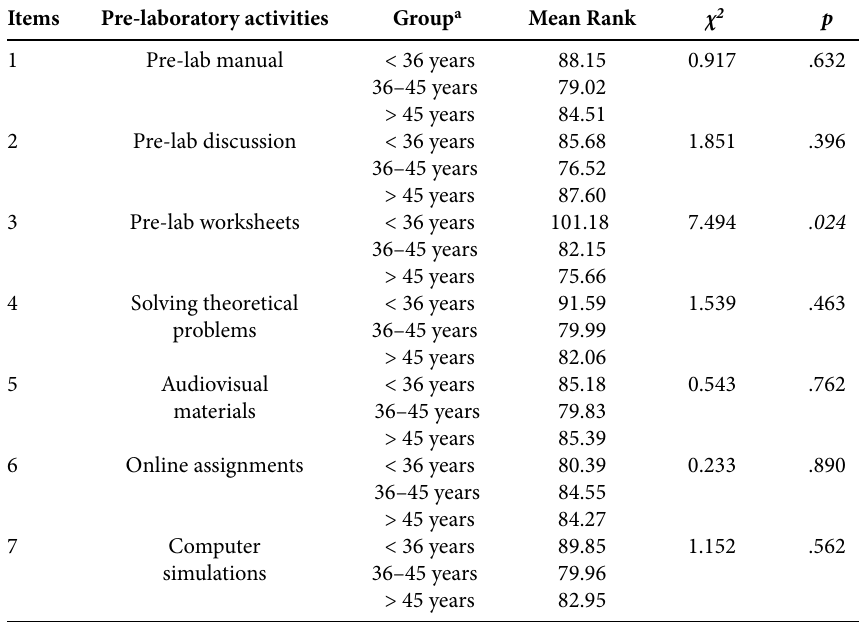
Table 5. The results of the Kruskal–Wallis H test of statistically significant differences in the chemistry teachers’ use of pre-laboratory activities regarding the age of teachers ( N (< 36) = 37; N (36–45) =